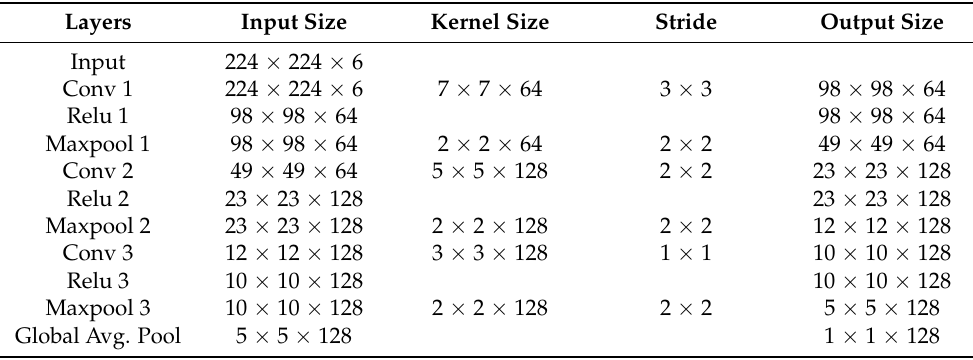
Figure 8. The proposed classification schemes . Table 5. The Proposed CNN network